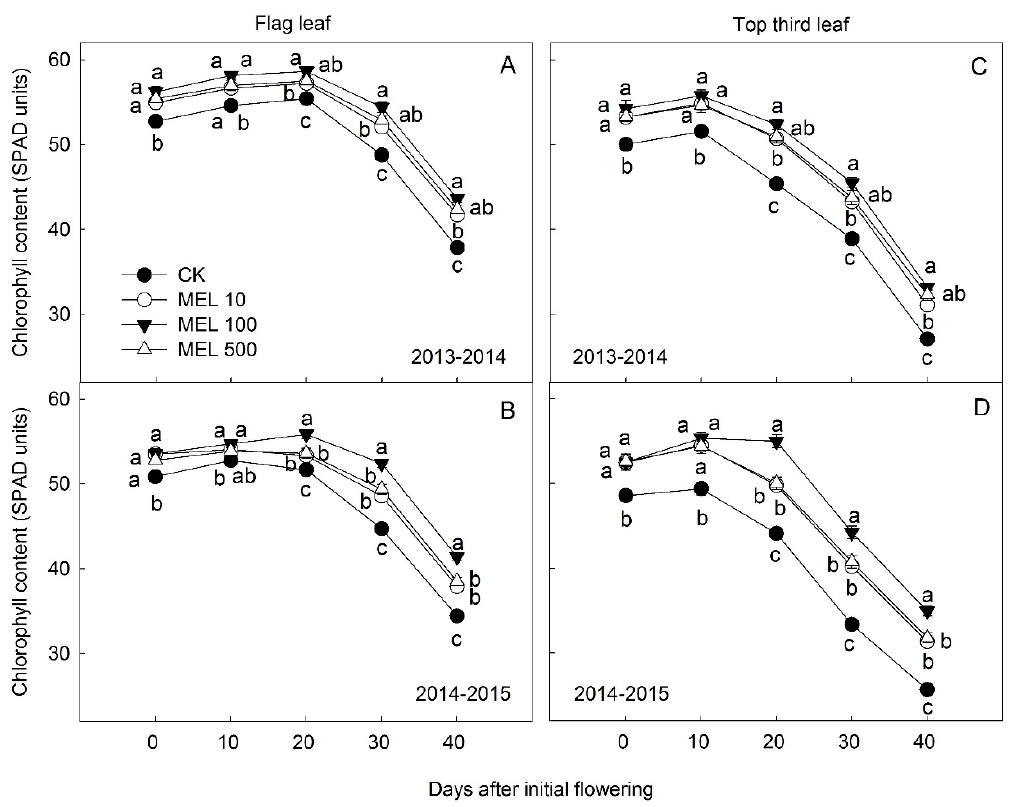
Figure 5. The effects of MEL application on chlorophyll content (SPAD units) after 0, 10, 20, 30 and 40 days of initial flowering. ( A , B ) are the chlorophyll contents of flag leaves in the 2013–2014 and 2014–2015 growing seasons, and ( C , D ) are for the top third leaves in two growing seasons. Values are means ± SEs of six replicates. Significant differences between different treatments on the same day of the experimental period are indicated by different letters ( p < 0.05).